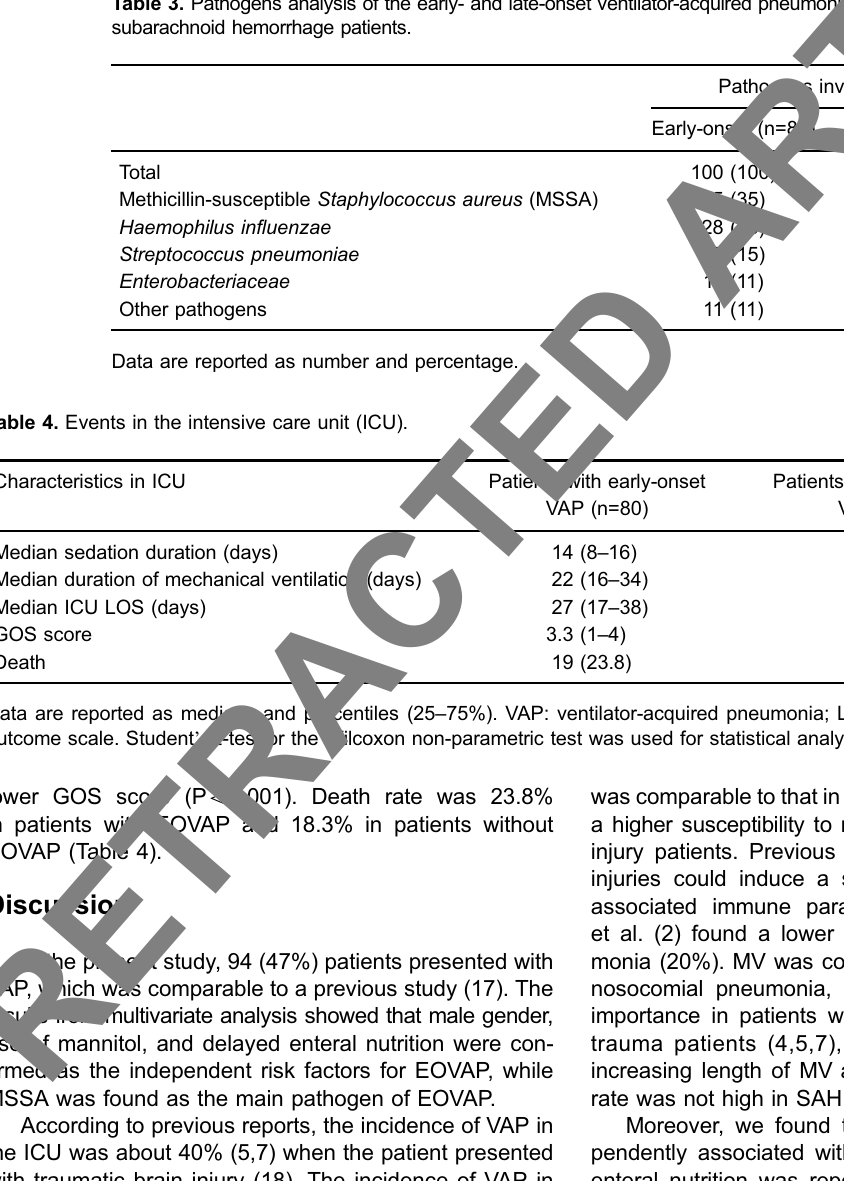
Table 3. Pathogens analysis of the early- and late-onset ventilator-acquired pneumonia (VAP) in aneurysmal subarachnoid hemorrhage patients.